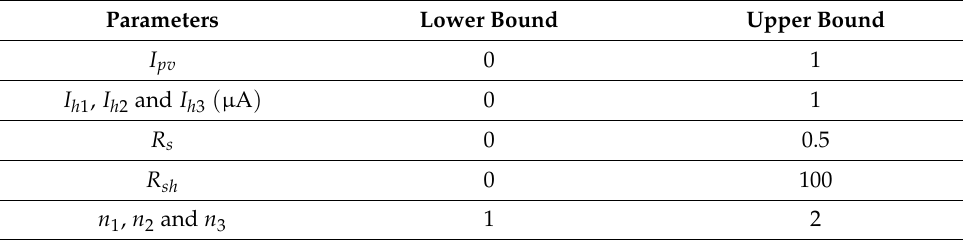
Table 1. The variables’ lower and upper boundaries.